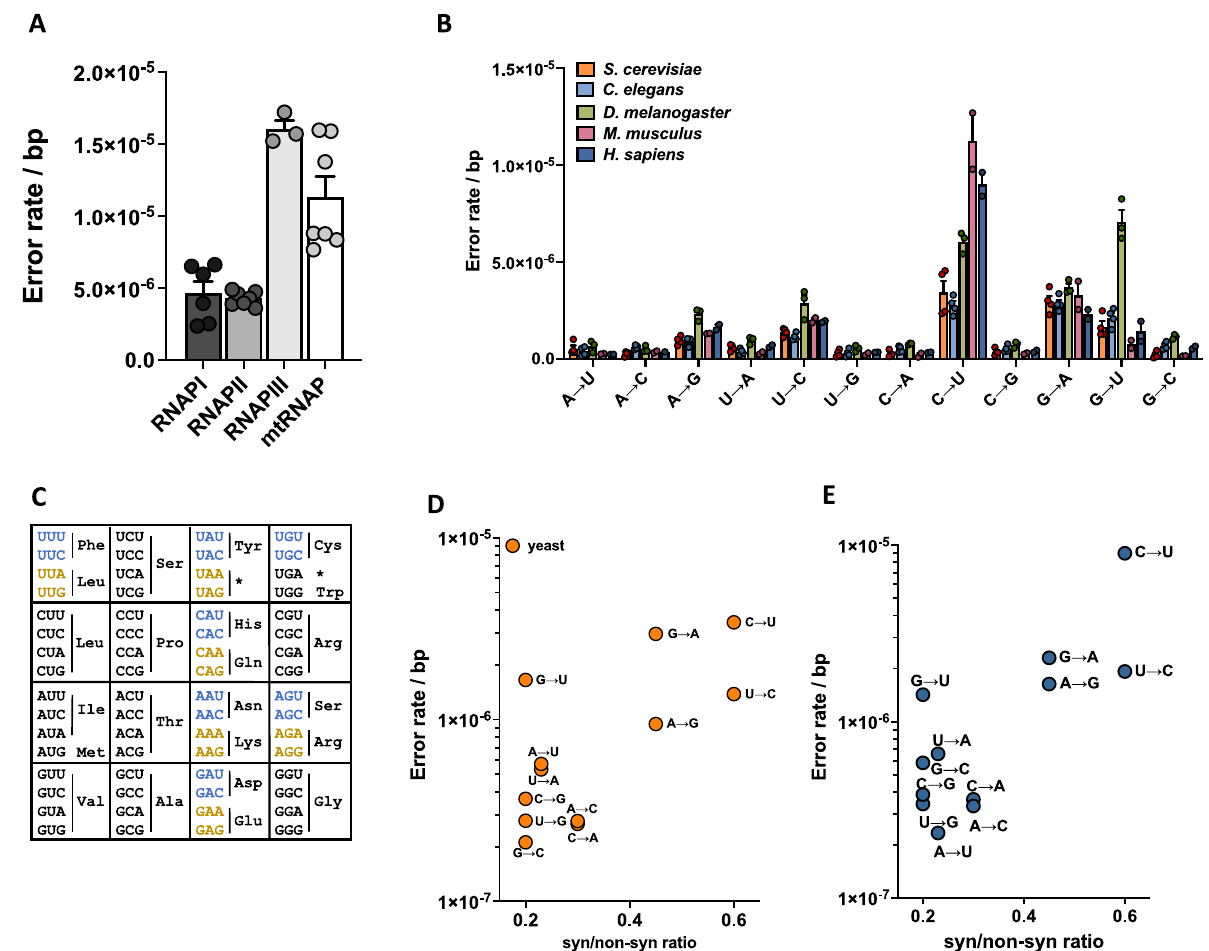
Fig.6|Theerrorrateoftranscriptioninvariouscelltypesandthegeneticcode. A The error rate of transcription in human cells ( n =7). B The error spectrum of transcriptioninorganismsofincreasingcomplexity( n =7foryeast, n =4forworms and fl ies, n =3formiceand n =7forhumancells). C Thegeneticcodeisconstructed in such a way that C → U and G → A errors do not result in mutated proteins if they occur in the “ wobble ” position. Errors that are more likely to result in a non- synonymous change, (as expressed by the ratio of synonymous to non-